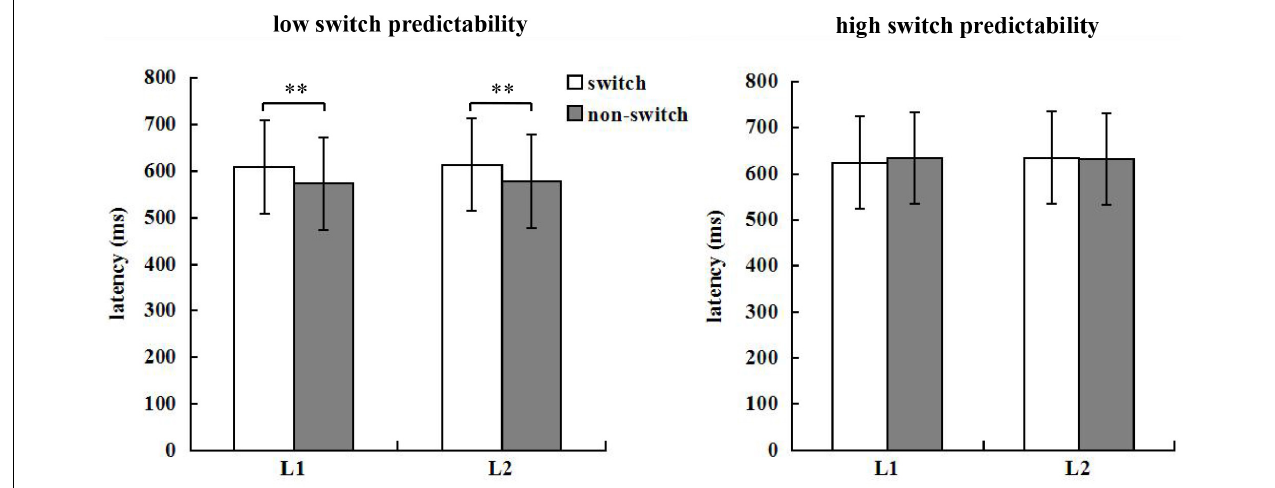
FIGURE 2 | Mean RTs across different conditions for the low and high switch predictability